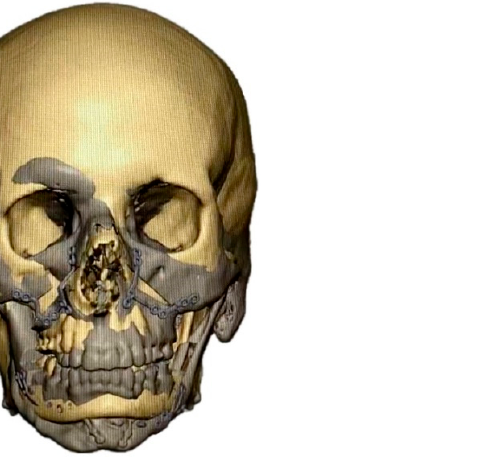
Figure 4. Superimposition of patient skull and standard skull (after adjustment of size). Superim- posed and color-marked are the planned postoperative hard tissue contours (gray) and the standard skull (beige).